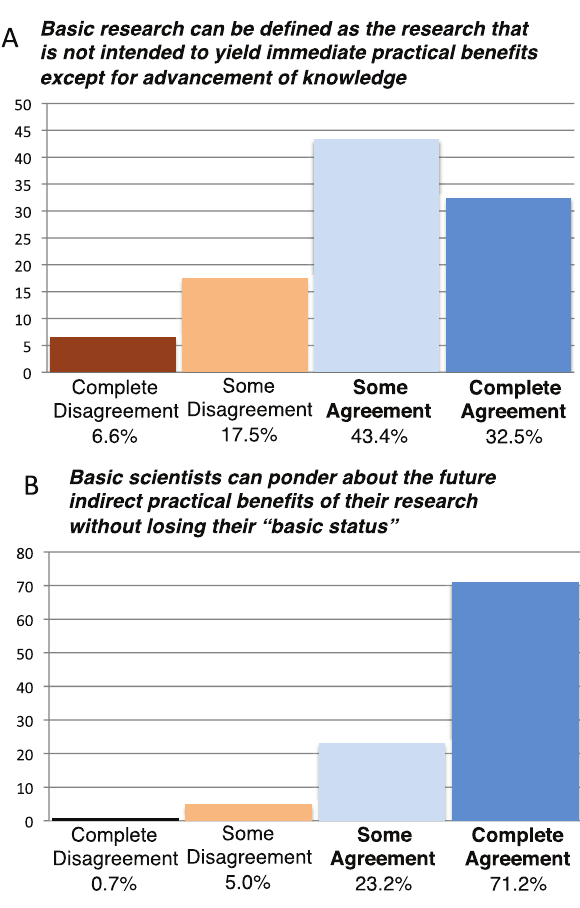
Figure 1. How do scientists conceptualize basic “bio” research? ( A ) Graph shows the levels of agreement to the following statement: “Basic research can be defined as the research that is not intended to yield immediate practical benefits except for advancement of knowledge”. 302 scientists answered the question; 2 skipped. ( B ) Graph shows the levels of agreement on the following statement: “Basic scientists can ponder about the future indirect practical benefits of their research without losing their “basic status””. 302 respondents answered the question; 2